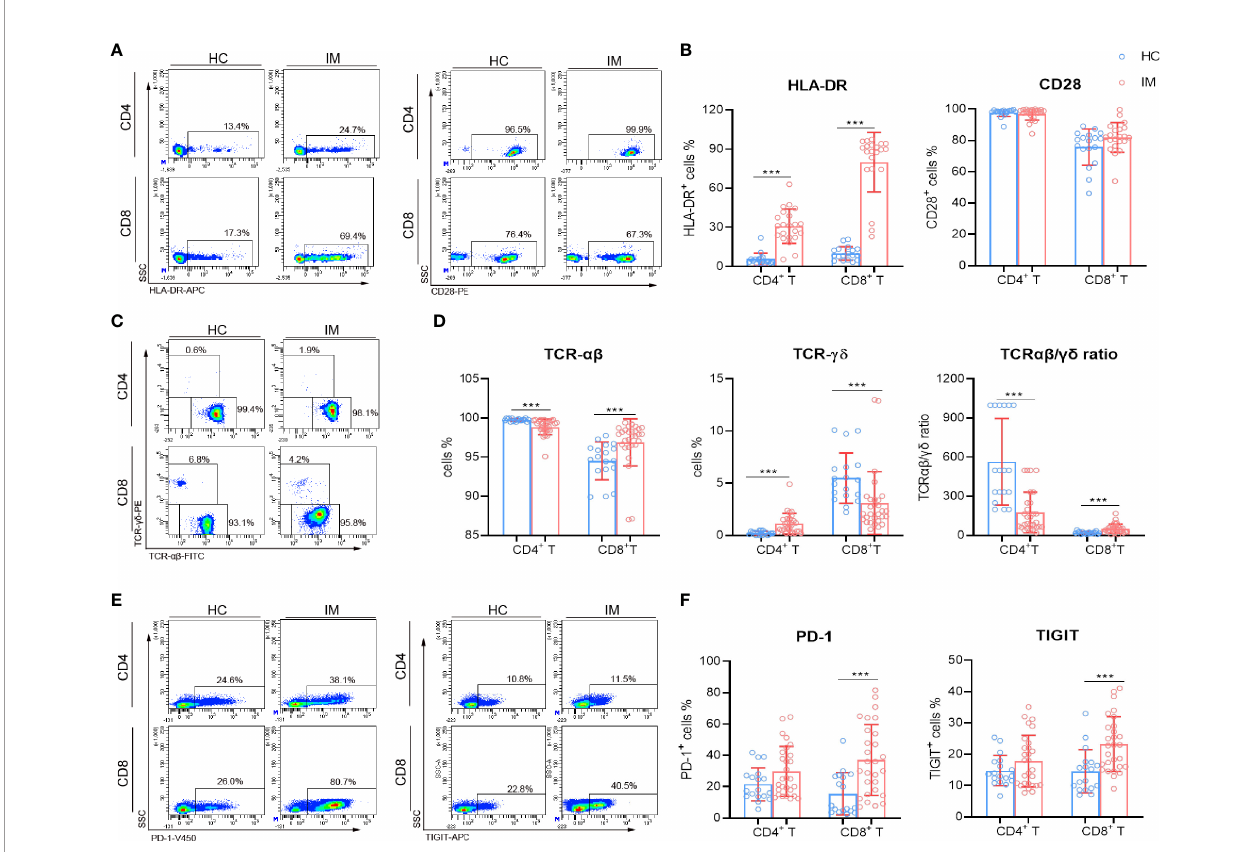
FIGURE 2 | Immunophenotype characteristics of T cells in IM patients. (A, B) Representative fl ow cytometry gating strategy for the expression of HLA-DR and CD28 in T cells. The percentages of HLA-DR and CD28 positive cells in CD4 + and CD8 + T cells from IM patients and HCs were expressed as mean with SD. (C) Representative dot plots showing the expression of TCR in CD4 + and CD8 + T cells. (D) The percentages of TCR- ab and TCR- gd positive cells and the ratio of TCR- ab and TCR- gd in CD4 + and CD8 + T cells were expressed as mean with SD. (E) Representative dot plots showing the expression of PD-1 and TIGIT in CD4 + and CD8 + T cells. (F) The percentages of PD-1 and TIGIT positive cells were expressed as mean with SD. Blue circle points represent HCs, and red circle points represent IM patients. *** p <